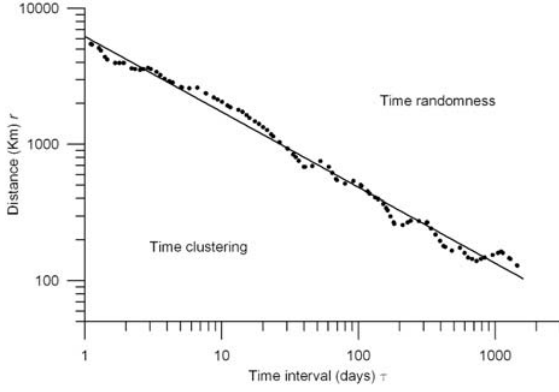
Fig. 3. The limit separating time clustering from time randomness (fixed to D t =0.8 ) as a function of distance is shown. Points are fitted by the line of equation log r =− 0.55log τ+